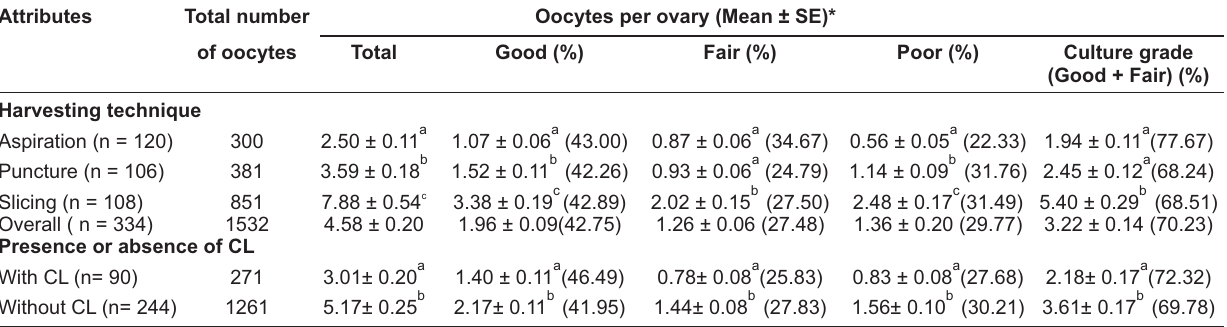
Table-1: Effect of different harvesting techniques and presence or absence of corpus luteum on the quantity and quality of oocytes recovered from buffalo ovaries.